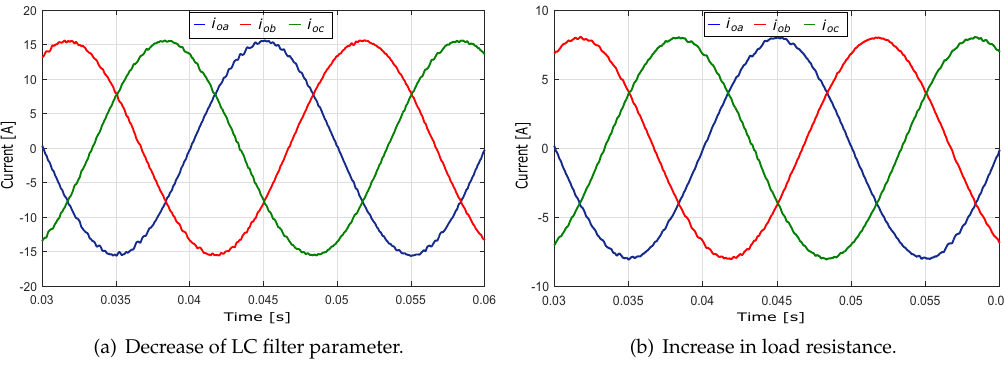
Figure 16. Output current with parameter